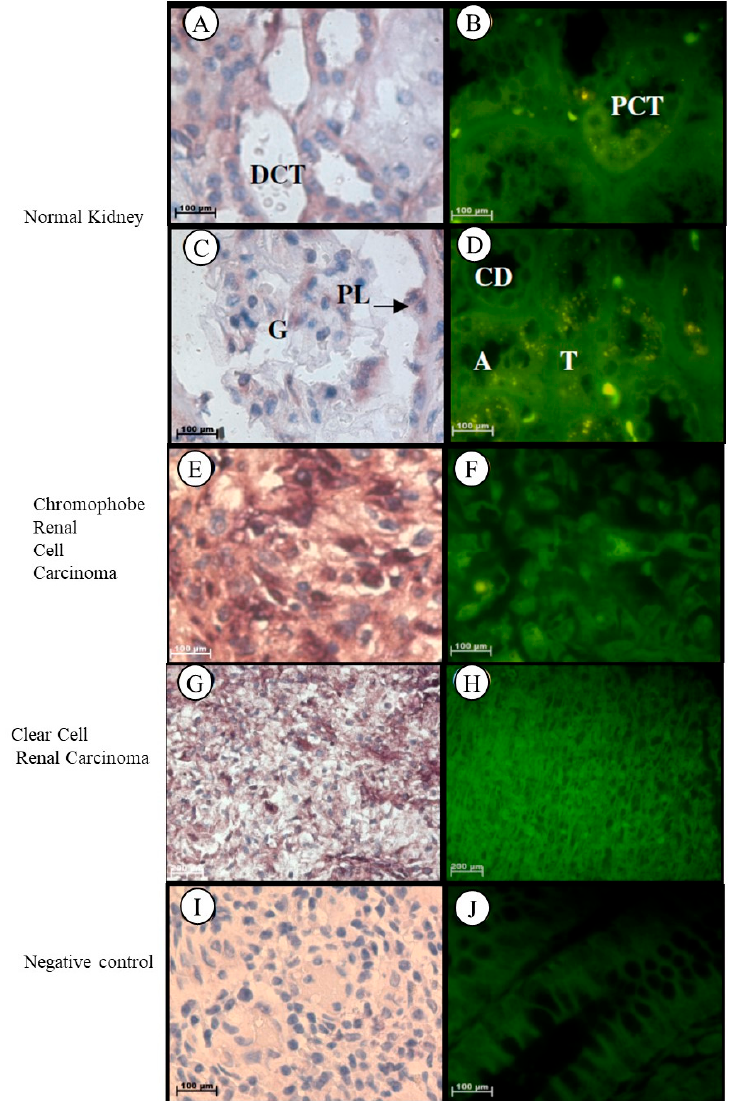
Figure 6. Subcellular Localization of Tspo mRNA in healthy and diseased Kidney Tissue: In healthy kidney tissue ( A – D ). Tspo m RNA is expressed in the cytoplasm of the flattened cells located in the parietal layer of the Bowman’s capsule, in the cytoplasm of endothelial cells that line the anastomosing network of capillaries of in the glomerulus (G), in the cytoplasm of the simple cuboidal epithelium that line the proximal convoluted tubule (PCT), in the cytoplasm of the simple squamous epithelium and erythrocytes within the vasa recta, in the cytoplasm of the simple squamous epithelium that lines the thin ascending and descending limbs (T), in the cytoplasm of the low cuboidal epithelium of the thick ascending limb (A), in the cytoplasm of the simple cuboidal epithelium of the distal convoluted tubule (DCT), in the cytoplasm of the simple cuboidal epithelium of the collecting tubule shape to the ascending limb and in the cytoplasm of the simple columnar epithelium that lines the collecting duct (CD). The transcription level of Tspo mRNA decreases in renal cell carcinoma ( F , H ) versus healthy kidney tissue ( B ). In Grade III chromophobe renal cell carcinoma ( E , F ) the mRNA is localized in the nuclei and cytoplasm of tumour cells that are usually arranged as a solid pattern with concentrations of the largest cells around the blood vessels. In renal clear cell carcinoma ( G , H ) the mRNA localizes in the nuclei and cytoplasm of tumour cells and in the cytoplasm of the delicate branching vasculature that appears fibromuscular. ( I , J ) Negative control for the subcellular localization of Tspo mRNA. Sense probes were used to probe tissue preparations and this was analysed colorimetrically and fluorescently . Tissues are magnified at 1000×.